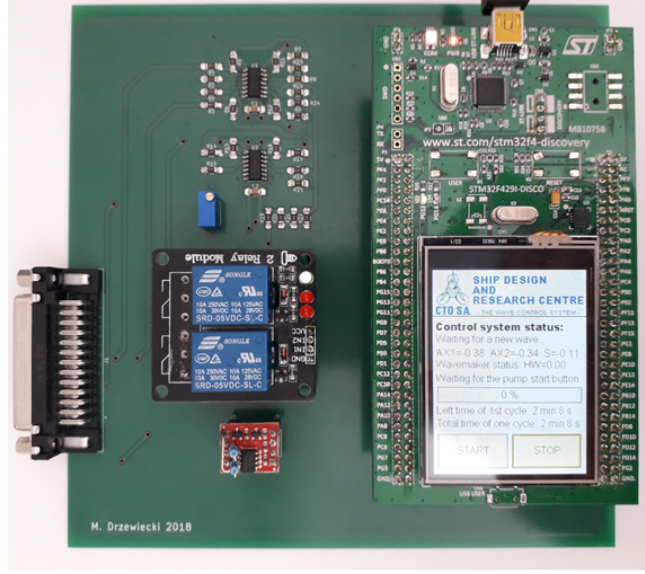
Figure 11. The wave maker embedded system, equipped with a Graphical User Interface